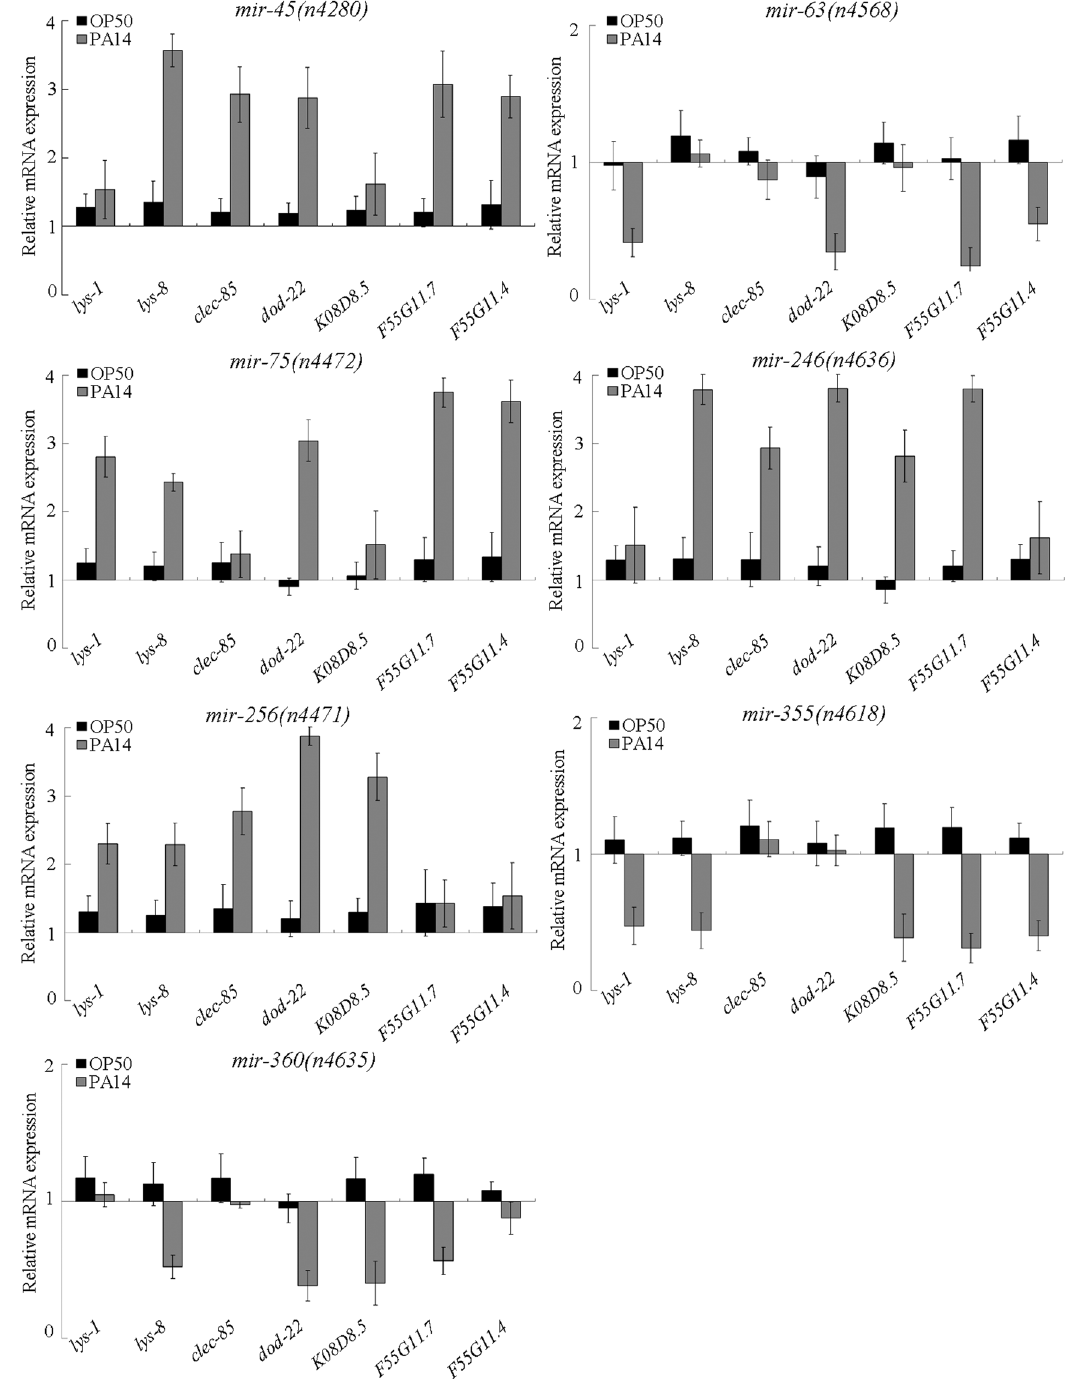
Figure 3. Expression patterns of putative antimicrobial genes in P. aeruginosa PA14 infected miRNA mutant nematodes. Normalized expression is presented relative to wild-type expression. Bars represent mean ±